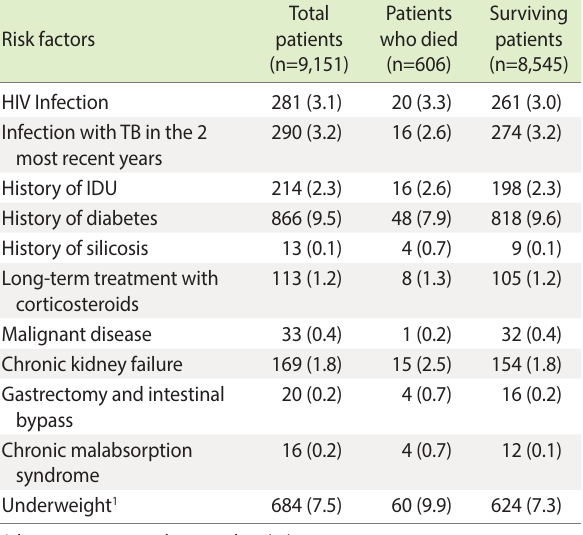
Values are presented as number (%).